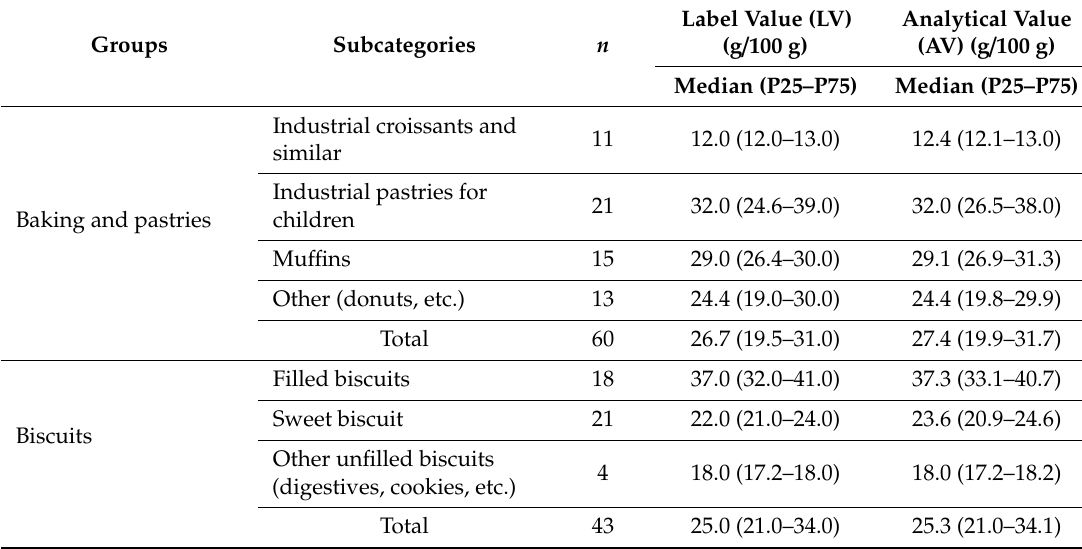
Table 5. Comparison of the label value (LV) and analytical value (AV) medians of the total sugar for each group and subcategory of products (appropriateness